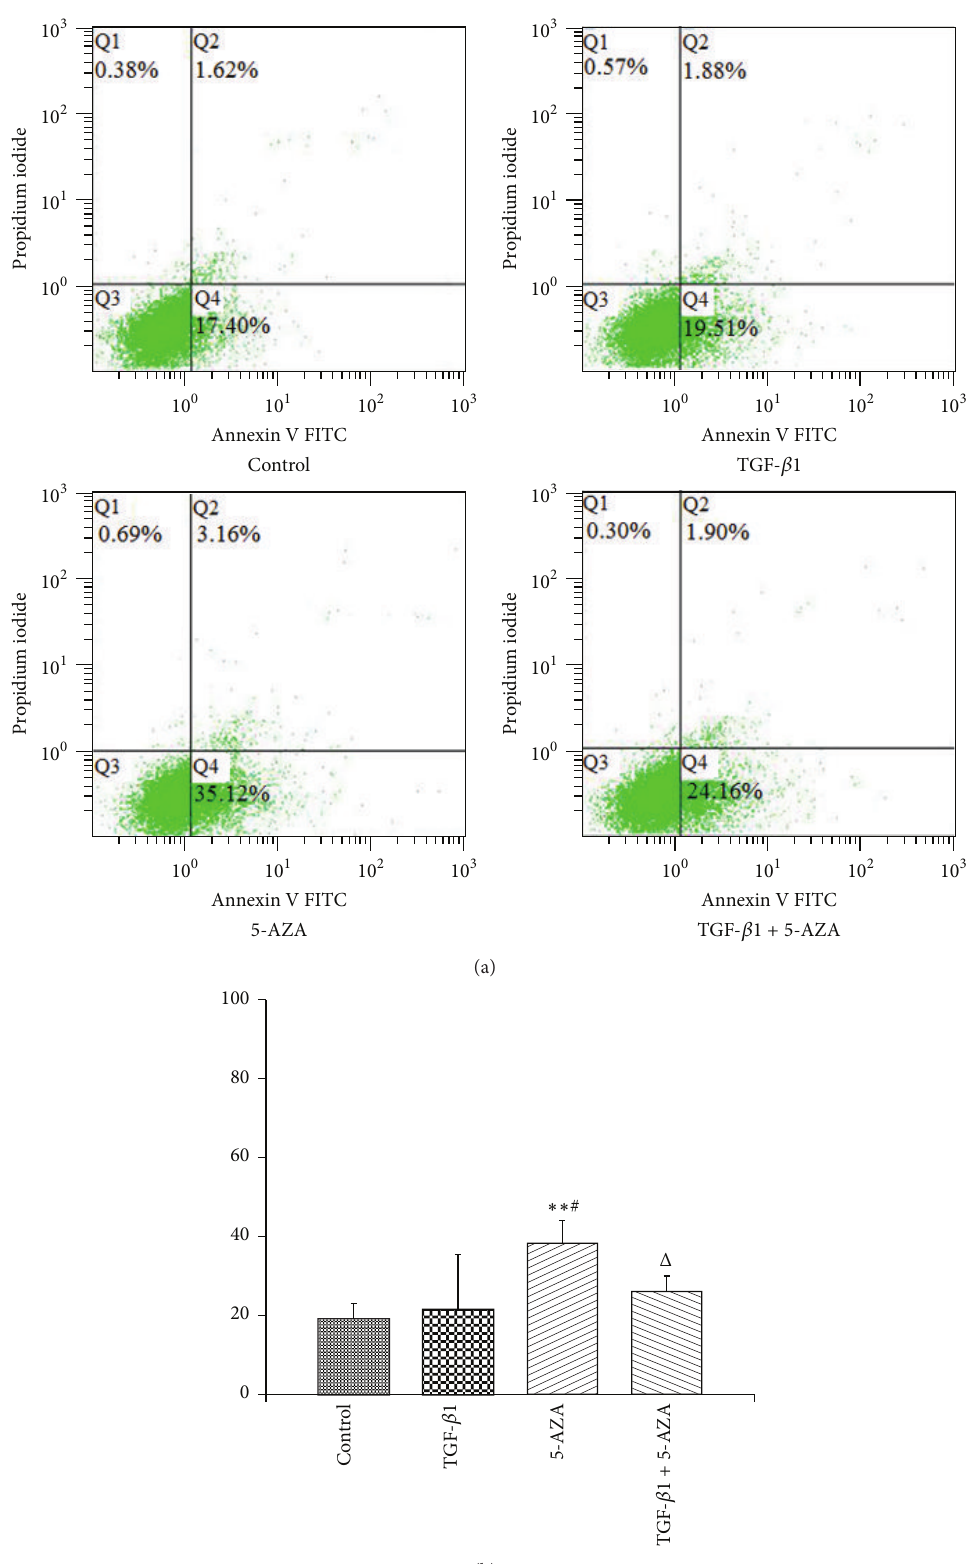
Figure 3: Cells apoptosis in different groups. Results are expressed as the means ± SEM. ∗∗ 𝑃 < 0.01 versus control group; # 𝑃 < 0.05 versus TGF- 𝛽 1 group; ΔΔ 𝑃 < 0.01 versus 5-AZA group ( 𝑛 = 3